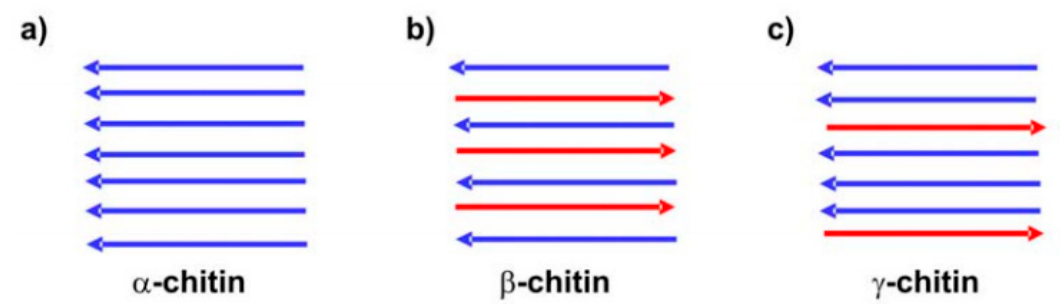
Figure 2. Three polymorphic configurations of chitin: ( a ) α -chitin, ( b ) β -chitin, ( c ) γ -chitin [8].